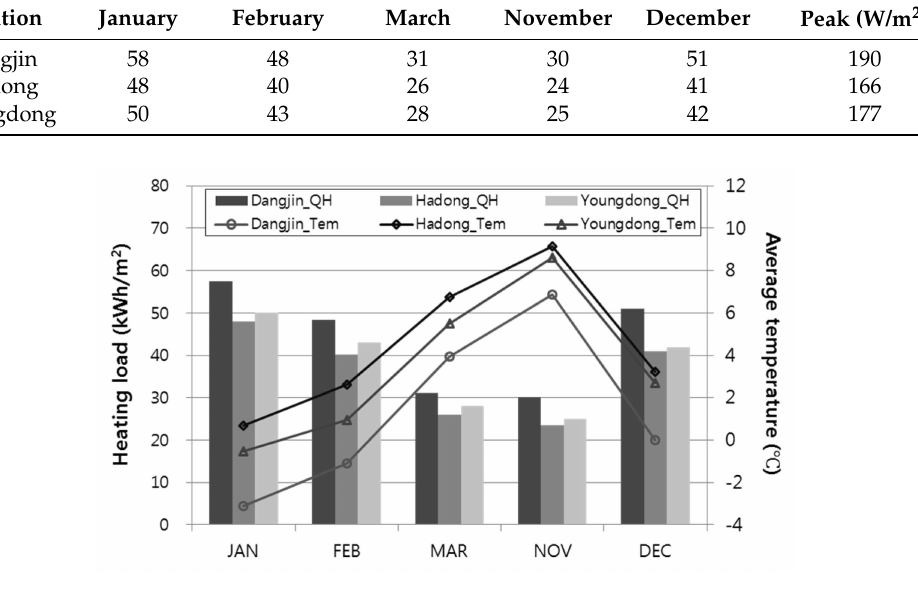
Figure 5. Heating load and average temperature of each case